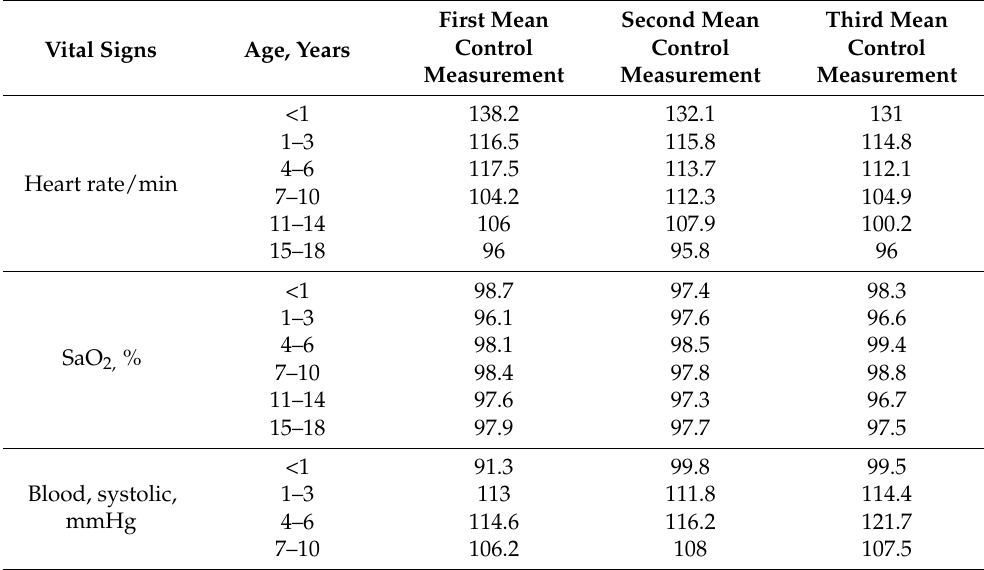
Table 4. Heart rate, oxygen saturation and blood pressure at three control measurements without music